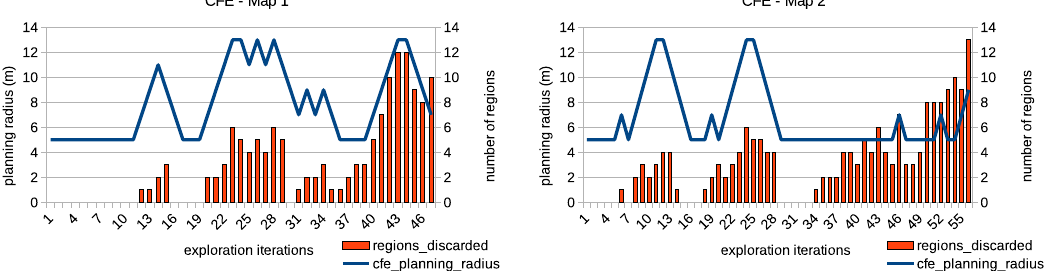
Figure 12. Number of regions discarded for each exploration iteration of the maps 1 and 2 using the CFE